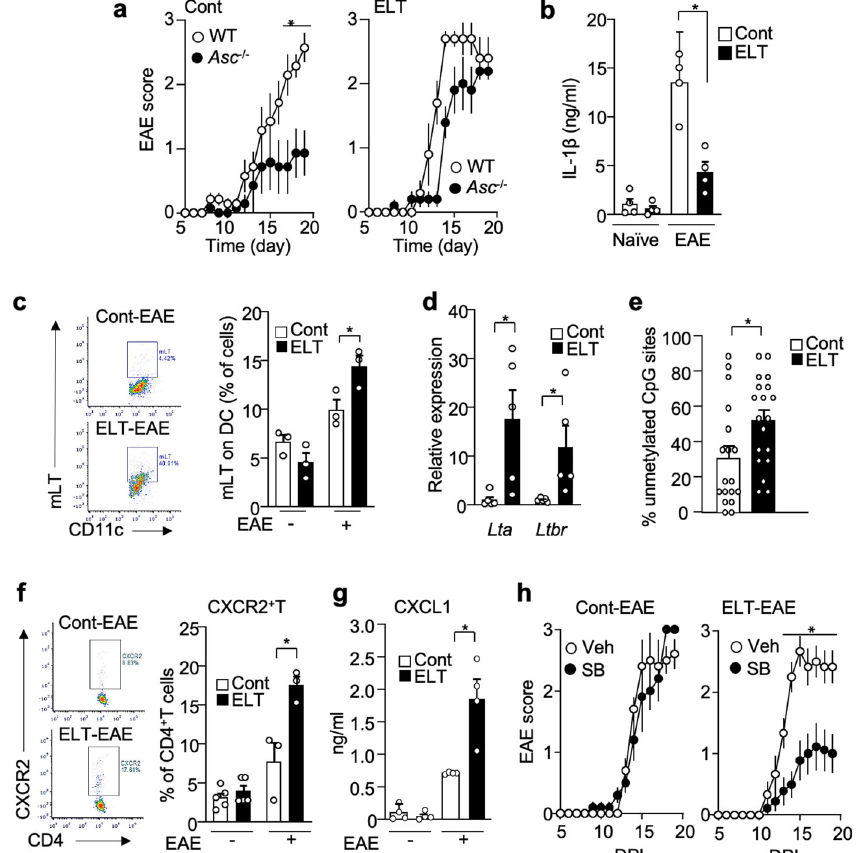
Fig. 5 Distinct immune markers in ELT-EAE mice. a EAE scores after EAE induction in control- and ELT mice of wild type and Asc − / − mice (Cont-WT: n = 4, Cont- Asc − / − : n = 5, ELT-WT: n = 6, ELT- Asc − / − : n = 5). b Serum levels of IL-1 β at 10 dpi (Cont naïve: n = 4, ELT naïve: n = 4, Cont EAE: n = 3, ELT-EAE: n = 3). c Percentage of mLT-expressing dendritic cells (DC) at 10 dpi ( n = 3 animals/group). d Expression of Lta and Ltbr mRNA in DC obtained from lymph nodes of control EAE and ELT-EAE mice at 10 dpi ( n = 5 animals/group). e Percentage of unmethylated CpG sites in the promoter region of LT gene in dendritic cells isolated from lymph nodes of control and ELT mice without EAE at 10 dpi ( n = 18 colonies). f Percentage of CXCR2-expressing CD4 + T cells at 10 dpi (Cont naïve: n = 5, ELT naïve: n = 5, Cont EAE: n = 3, ELT-EAE: n = 3). g Serum levels of CXCL1 at 10 dpi ( n = 4 animals/group). h EAE score of mice treated with CXCR2 inhibitor SB225002 (SB) or saline (Cont-Vehicle: n = 5, Cont-SB: n = 5, ELT-Vehicle: n = 6, ELT-SB: n = 9). Male mice were used for experiments. Each dot represents averaged data per animal. Data are represented as mean ± SEM. Two-tailed Student ’ s t -test, * P < 0.05. Exact P values for asterisks (from left to right): a 0.0131; b 0.0032; c 0.0449; d 0.0252, 0.0447; e 0.0210; f 0.0221; g 0.0088; and h cellular markers as observed previously in the animal model and chemokine receptor CXCR2 expression in T cells. Consistent in interferon- β -resistant clinical cohort 27 . Namely, Inoue et al. with experimental evidence, peripheral blood mononuclear reported that interferon- β -resistant EAE model was characterized cells isolated from interferon- β non-responder patients with by heightened membrane lymphotoxin (mLT: a heterotrimer MS highly express LT β R and CXCR2 compared to interferon- β containing LT α and LT β 30 ) expression in APCs and upregulated responder patients 27 . In comparison to control EAE mice,